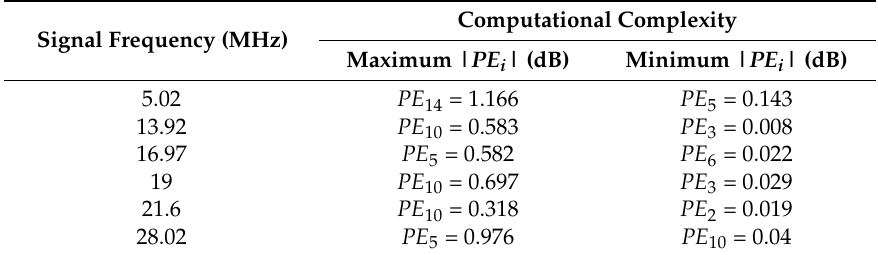
Table 1. The maximum and minimum absolute values of PE i versus different frequency points.